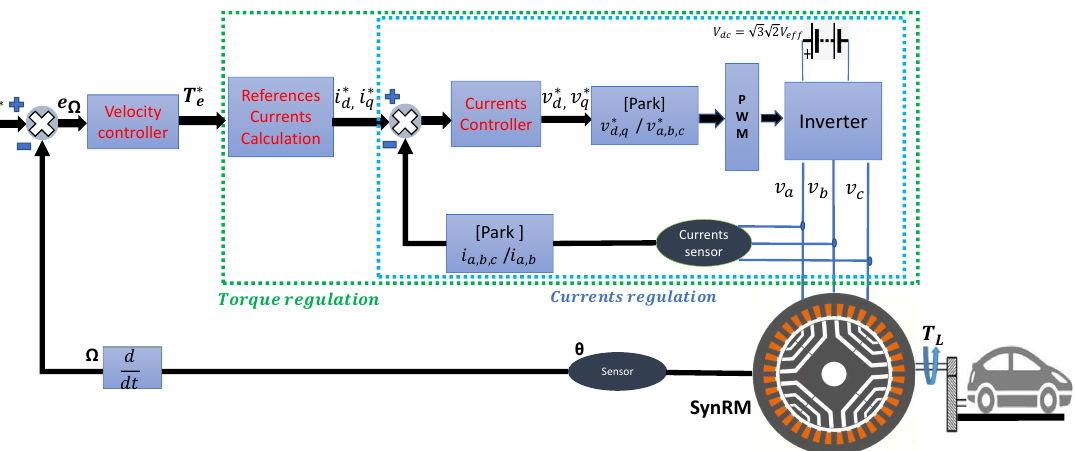
Figure 4. Block diagram of the cascade velocity/currents control strategy